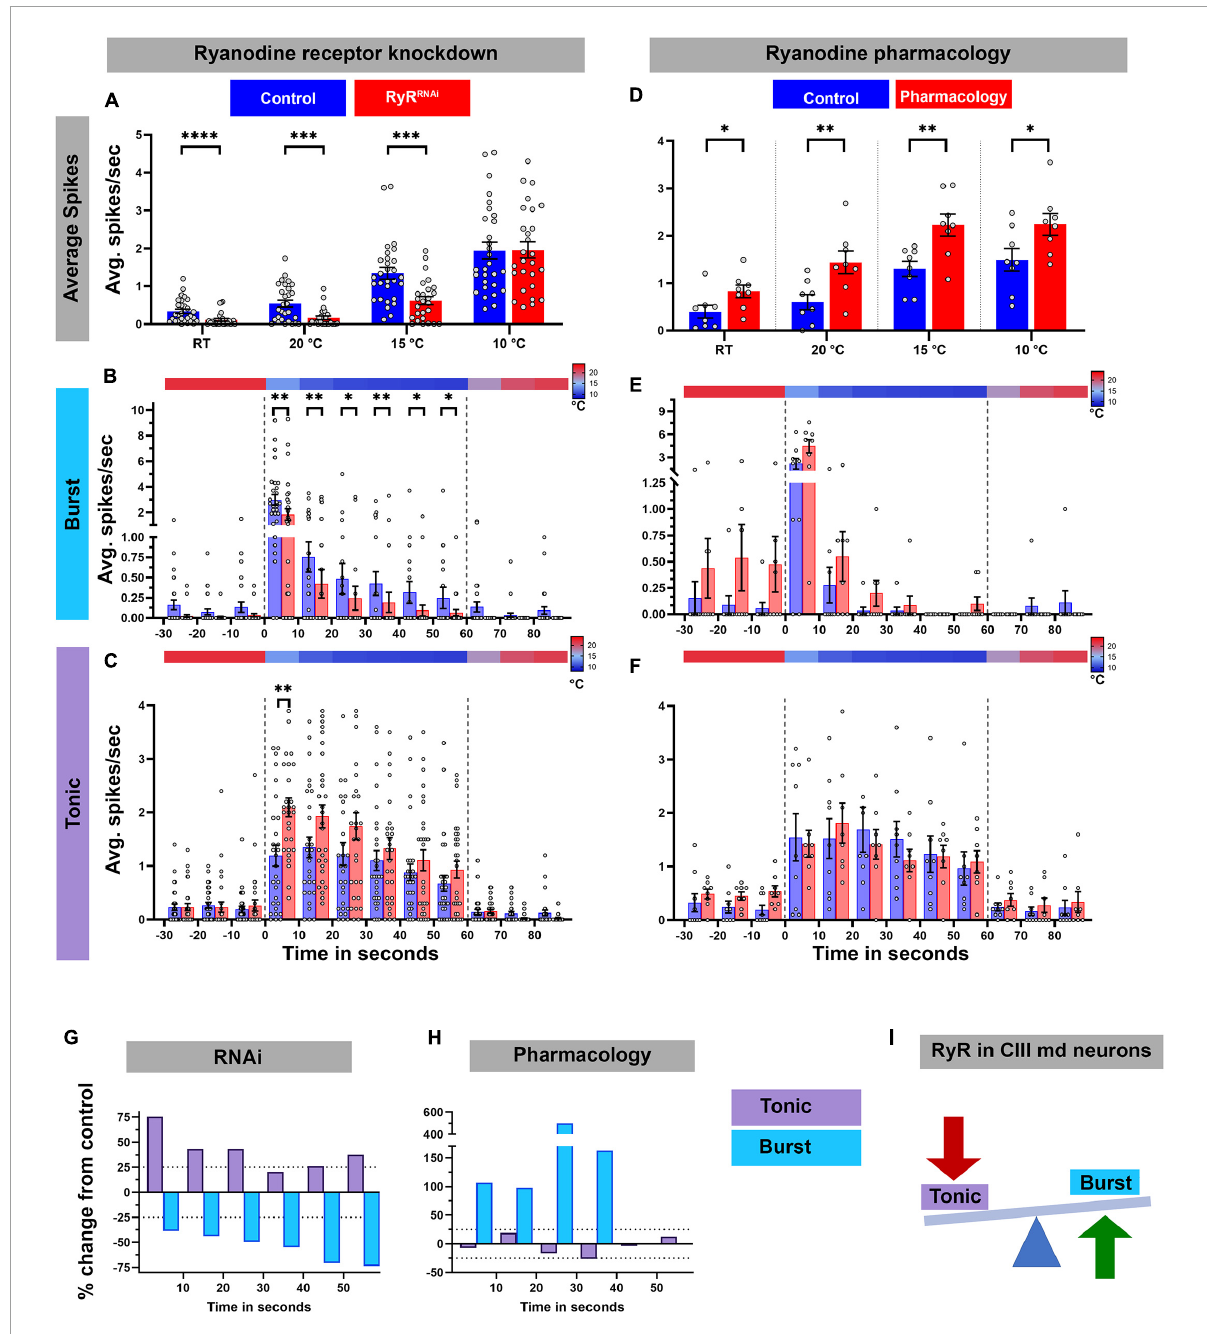
FIGURE6 Ryanodine receptor mediates cold-evoked bursting in CIII md neurons. (A–C) Average spike rate of GFP tagged CIII md neurons expressing RyR RNAi compared to control. (A) Average spikes/seconds of CIII md neurons at room temperature (RT) or cold stimulations (20, 15, and 10 ◦ C). N Average = 29. Statistics: Multiple Mann–Whitney tests with Benjamini, Krieger, and Yekutieli for multiple comparisons. (B,C) 10 ◦ C stimulus evoked bursting spike rate (B) and tonic spike rate (C) . Individual spikes are considered to bursts, if inter spike interval is less than 0.15 s for at least three spikes and rest of the spikes counted as tonic spikes. Heatmap above each graph represents stimulus temperature. Spike rate is calculated in 10 s bins. Statistics: Multiple Mann–Whitney test with Benjamini, Krieger, and Yekutieli for multiple comparisons. (D–F) Average spike rate of GFP tagged CIII md neurons in response to cold stimulus under ryanodine (10 − 6 M) pharmacology application. (D) Average spikes/seconds of CIII md neurons at room temperature (RT) or cold stimulations (20, 15, and 10 ◦ C). N Average = 8. Statistics: Multiple Wilcoxon tests with Benjamini, Krieger, and Yekutieli for multiple comparisons. (E–F) 10 ◦ C stimulus evoked bursting spike rate (E) and tonic spike rate (F) . (G,H) Percent change from control for bursting or tonic firing in RyR knockdown (G) or ryanodine application (H) at 10 ◦ C. (I) CICR mechanism through RyR functions in generating cold-evoked burst firing pattern in CIII md neuron. Significant differences indicated via asterisks, where ∗ p < 0.05, ∗∗ p < 0.01, ∗∗∗ p < 0.001, and ∗∗∗∗ p <